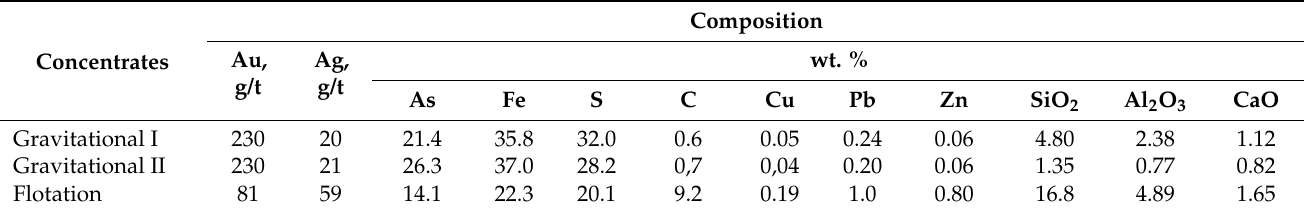
Table 2. Composition of Bakyrchik